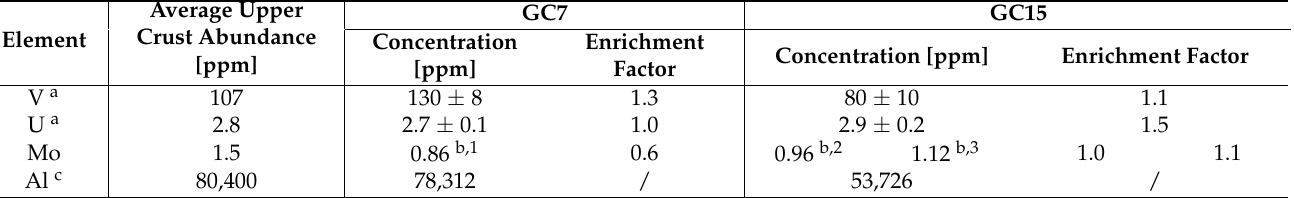
Table 2. Average trace metal concentrations in GC7 and GC15 and corresponding enrichment factors calculated with respect to the average upper crust abundance [36].